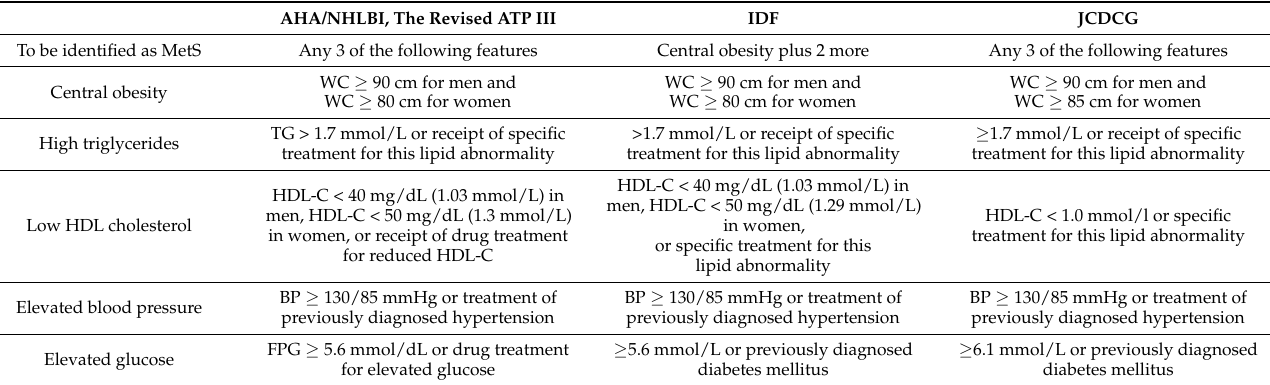
Table 1. Criteria for metabolic